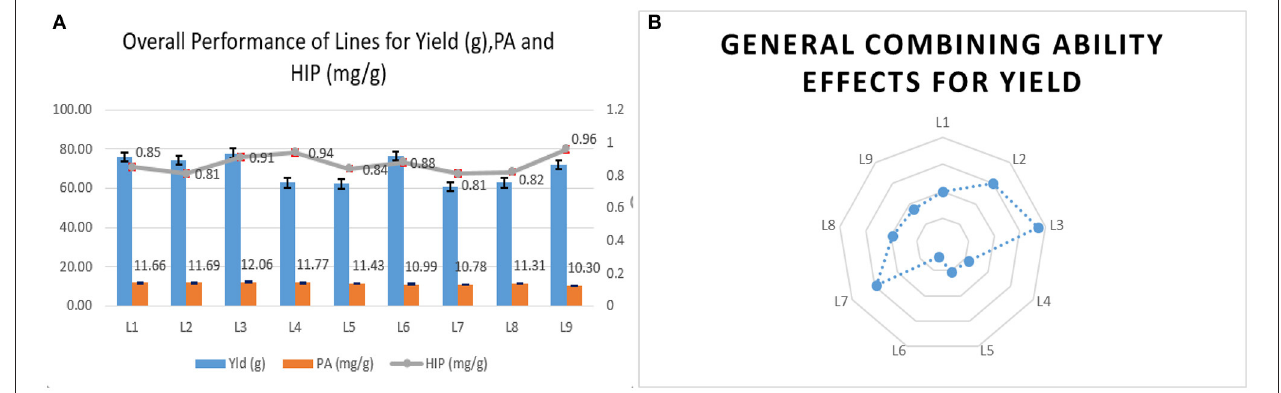
FIGURE 1 | The general mean performance and combining ability of female lines. (A) The overall mean performance of the female lines for single plant yield (g), phytic acid (PA), and high inorganic phosphorus (HIP) in mg/g. (B) The overall performance of the female lines in a series of crosses ( gca ) is depicted.